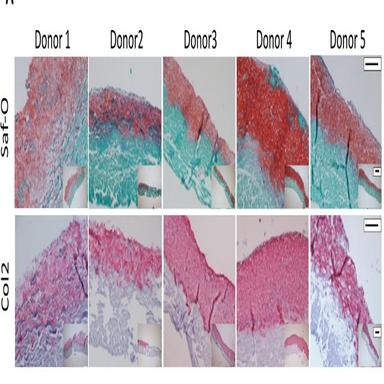
Histological analysis (Safranin-O, Saf-O, top pictures and type II collagen, Col2, bottom pictures) of the N-TEC generated with the modified process using cells from five donors (A). Staining of worst- and best-quality N-TEC generated with the standard process and representative staining of N-TEC generated with P2 or P4 cells with the modified process. Histological slides are oriented in the way to have on the top view the newly deposited cartilage matrix (in the seeded cell-permeable layer of the Chondro-G